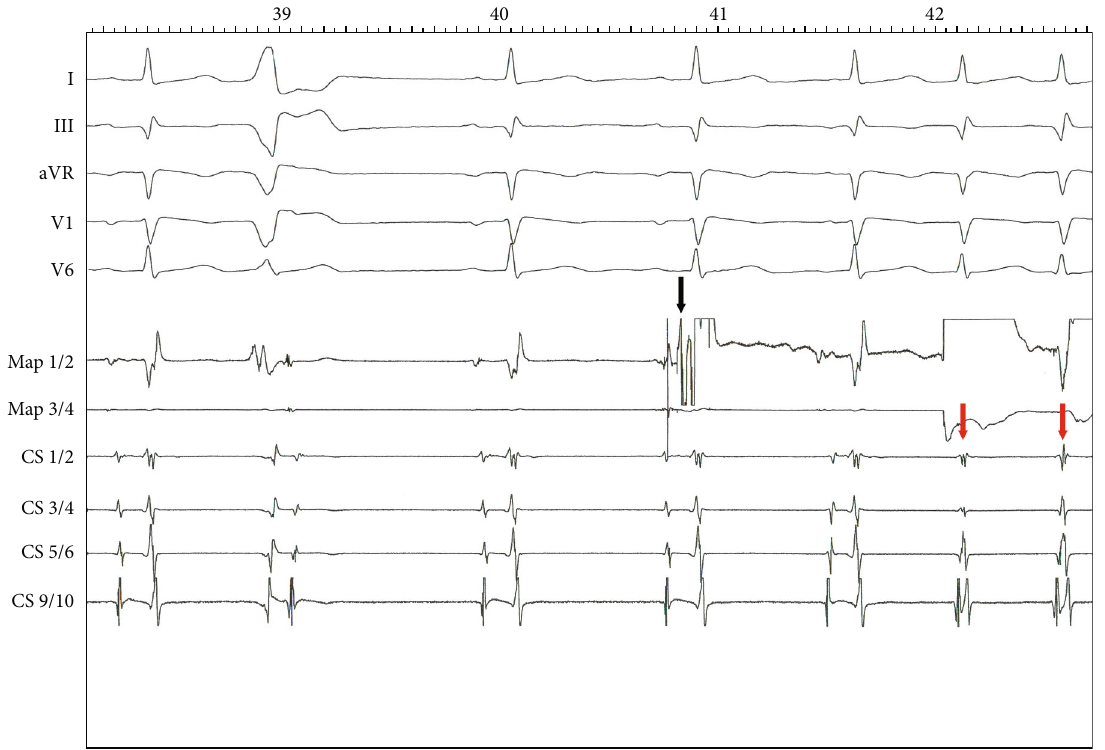
Figure 6: Electrogram of the ablation (black arrow: ablation start; red arrows: junctional beats after application of radiofrequency (RF)). A small A and a large V potential were recorded immediately before the